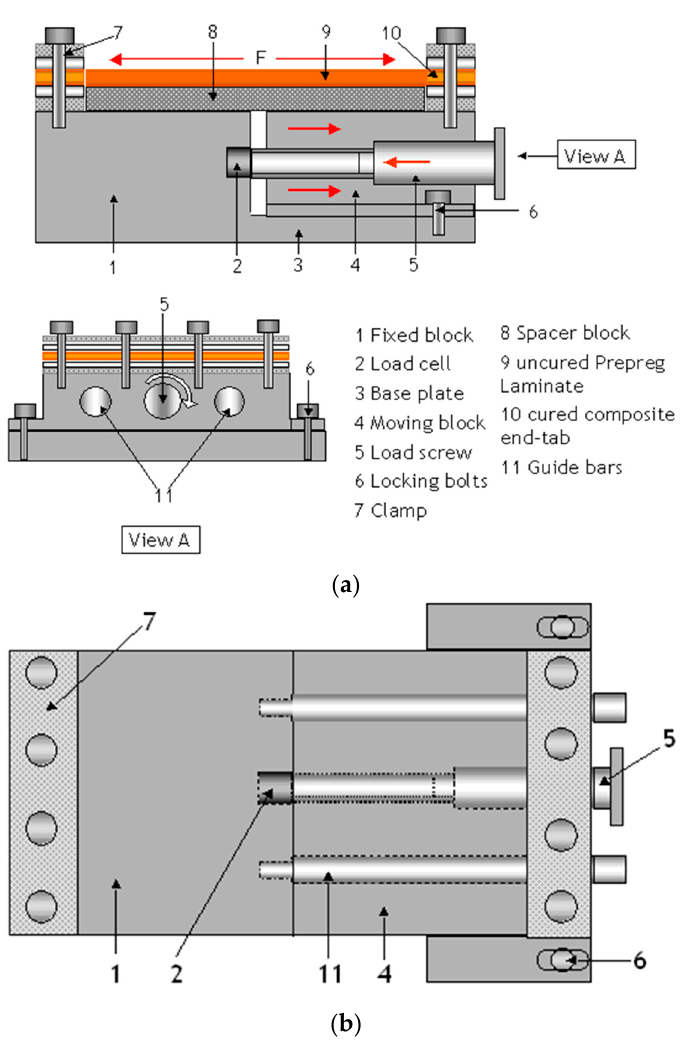
Figure 8. ( a ) Side-elevation of the flatbed rig for applying the desired pre-stress on laminated prepregs; ( b ) Top-elevation of the flat-bed pre-stressing rig.